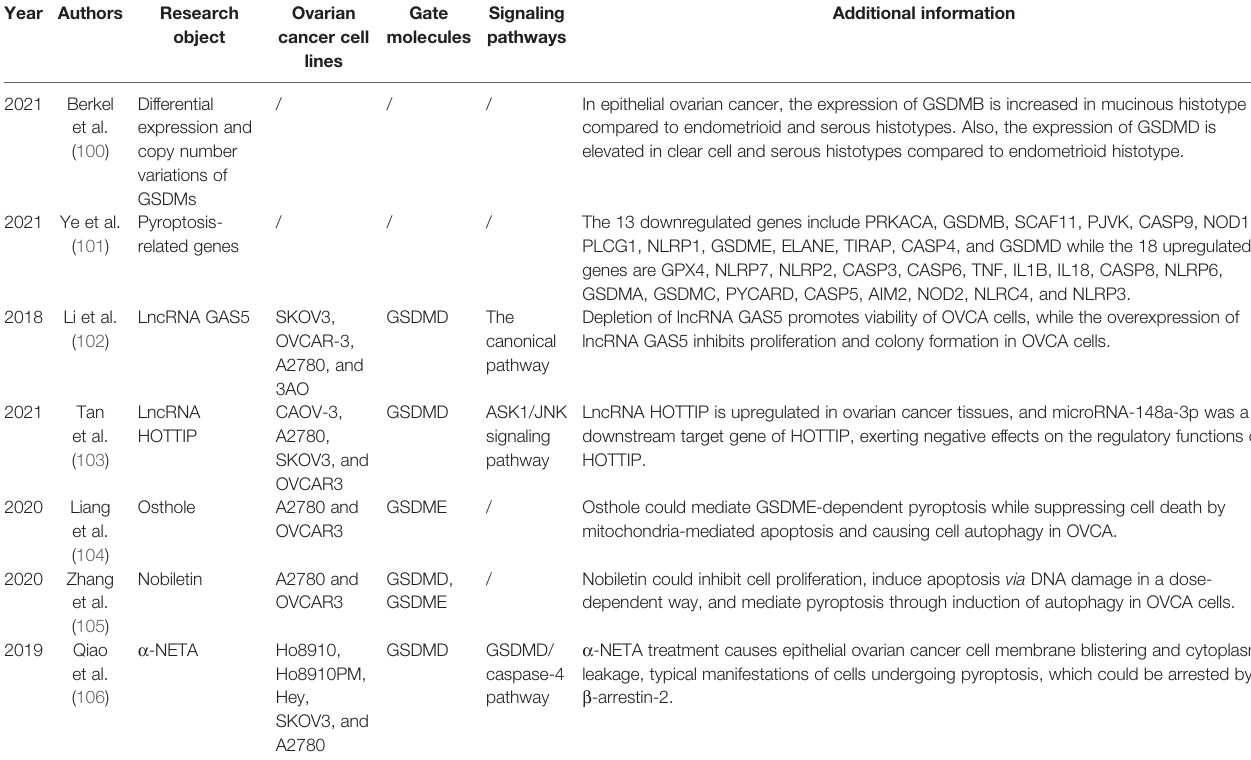
TABLE 1 | Current research foundations of pyroptosis and ovarian